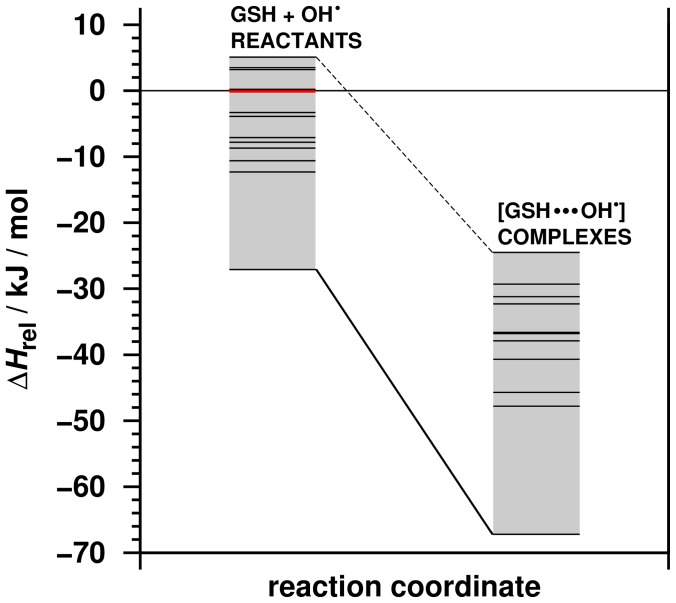
The relative enthalpy of the optimized GSH conformers and the GSH/OH• complexes.The reference conformer (red line) was the representative structure obtained from the molecular dynamics simulation of GSH without OH•. The calculations were carried out at the BHandHLYP/6-31G(d) level of theory combined with the SMD implicit (continuum) solvent model.